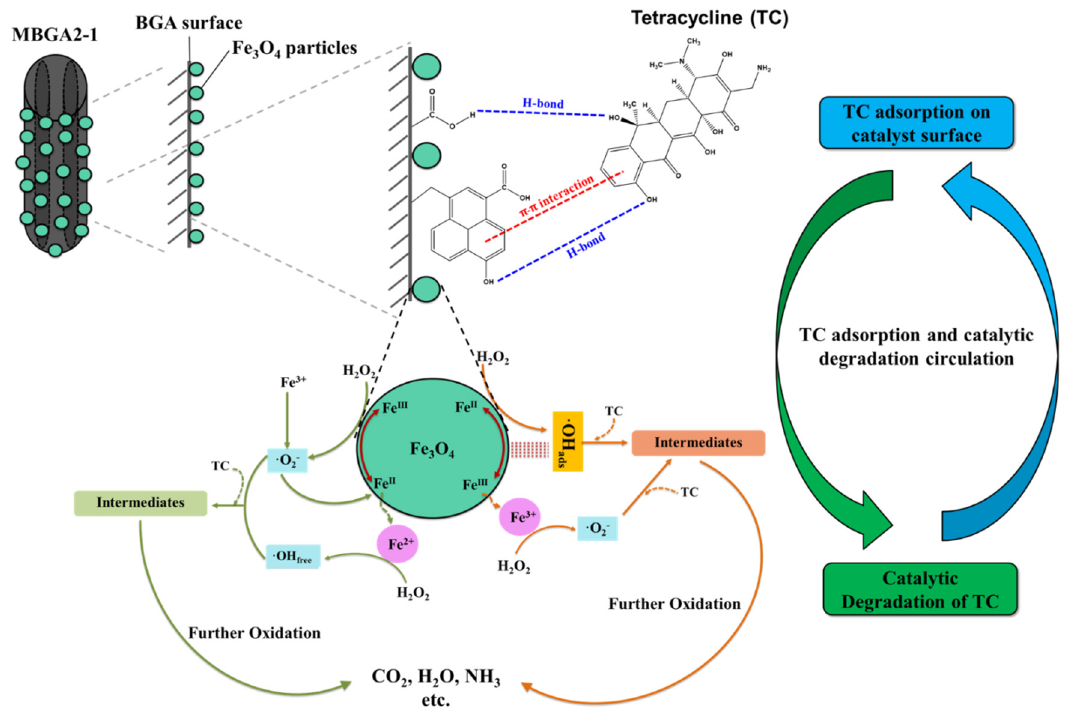
Figure 5. The TC catalytic degradation mechanism.